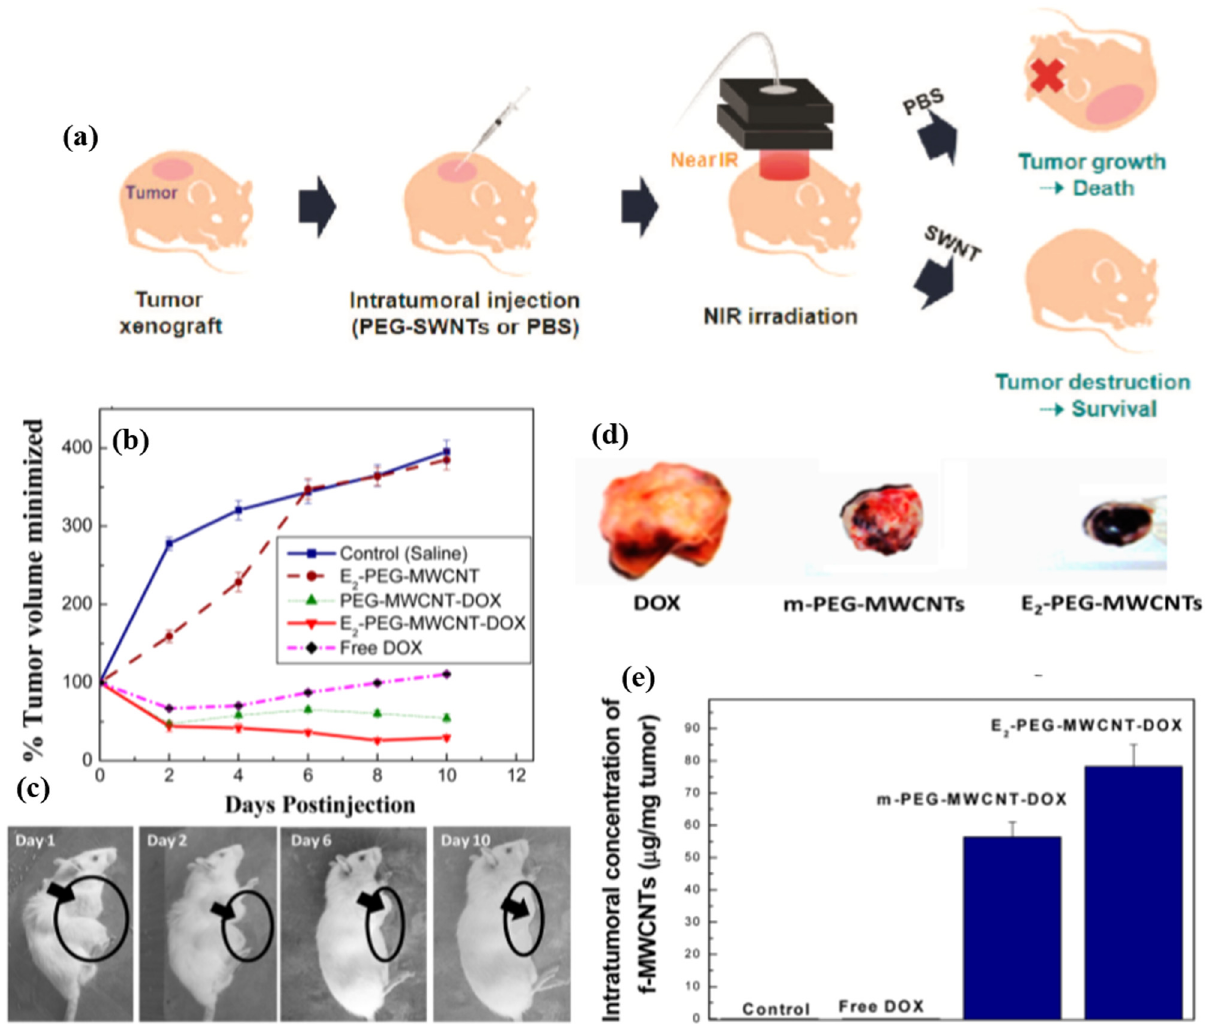
Figure 16: ( a ) Schematic of the procedure and results of polyethylene glycol - carbon nanotubes ( PEG - CNTs )- mediated photothermal treatment of tumors in mice [ 121 ] . Copyright 2009, Elsevier. ( b ) In vivo tumor growth inhibition of SD rats intravenously administered with free DOX and various MWCNT preparations loaded with an equivalent amount of the free drug. ( c ) Typical photograph of tumor reduction in rats treated with DOX@E2 - PEG - MWCNTs over time. ( d ) A photograph and ( e ) spectrophotometric data of DOX@MWCNTs [ 122 ] . Copyright 2013, American Chemical